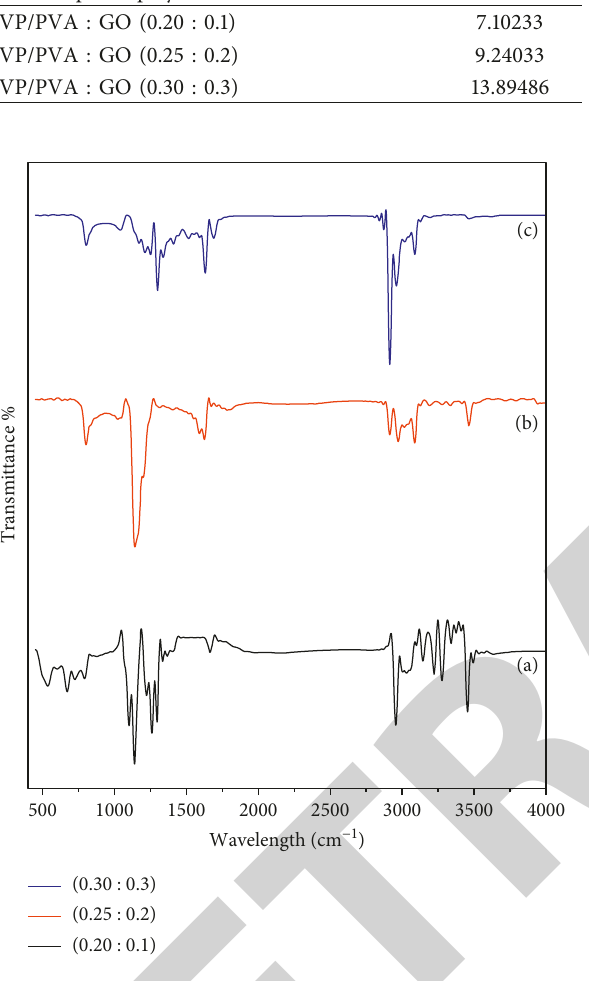
Figure 2: FTIR spectra of polymer electrolyte films for different PVP/PVA : GO wt.% ratios of (0.20 : 0.1), (0.25 : 0.2), and (0.30 :